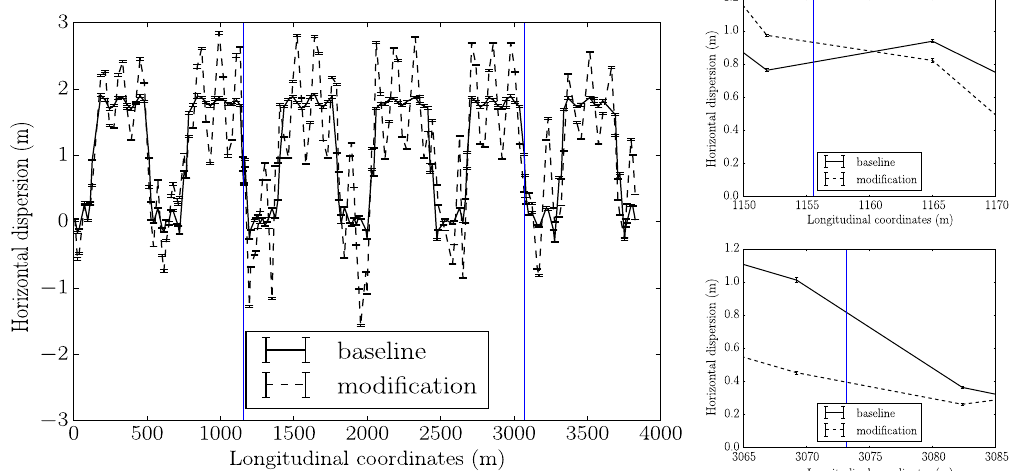
FIG. 5. Left plot: The measured horizontal dispersion functions in the blue ring at the beam position monitors at injection energy before (the solid line) and after (the dashed line) matching of the dispersion primes at the two Siberian snakes (located at the vertical lines). Right plots: Expanded view of the dispersion functions at the first snake (the upper plot) and the second snake (the lower plot).